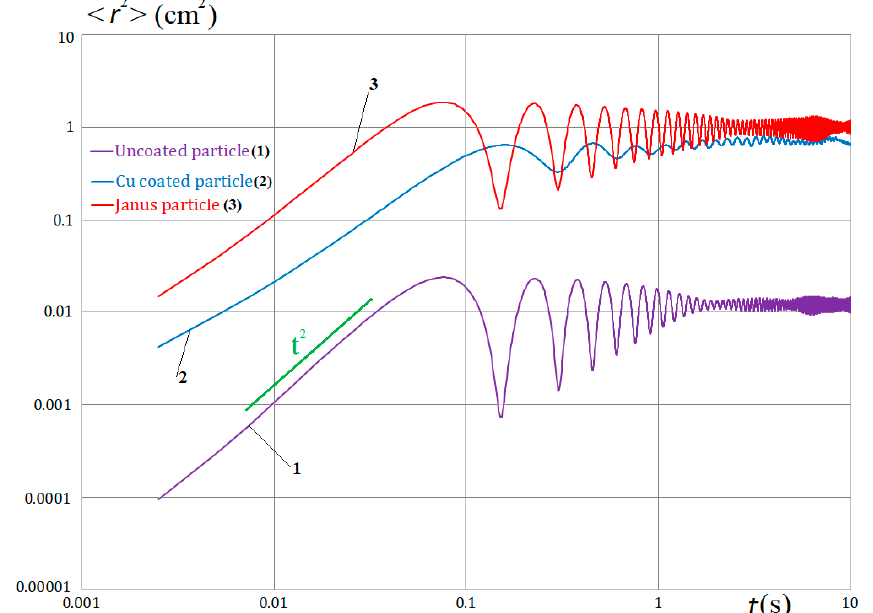
Figure 4. Root mean square (RMS) displacement of the single dust particles under the action of a 1300 mW laser: curve 1 for uncoated dust particle; curve 2 for Cu-coated dust particle; curve 3 for Janus particle.